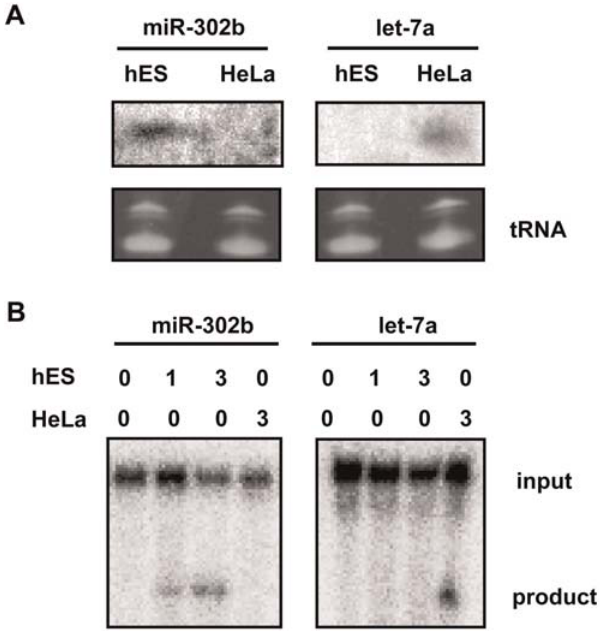
Figure 4. RISC in hES cells retains specific target RNA cleavage activity. (A) Northern blot analysis of miR-302b and miR let-7a expression in hES and HeLa cells, respectively. Total RNA was prepared from hES and HeLa cells and RNAs (10 m g) were loaded onto gels and miRNA bands were resolved by 14% denaturing gels. miRNAs were hybridized with various 32 P labeled specific DNA probes as